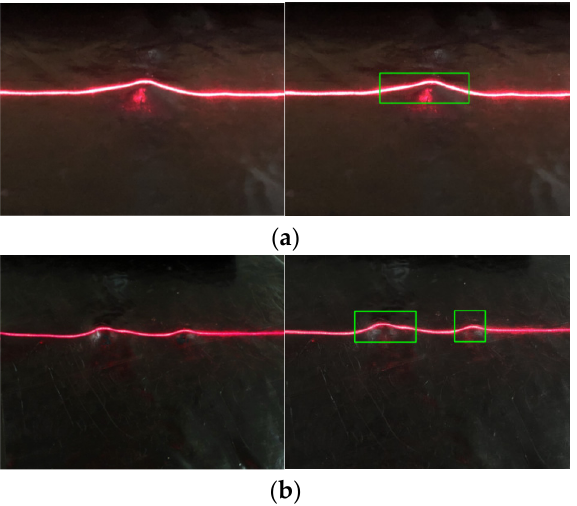
Figure 13. Comparison of test results, the left side is the original bubble image, and the right side is the image after detection: ( a ) represents a single bubble, ( b ) represents multiple bubbles. Table 1. Accuracy comparison of different tire defect algorithms.